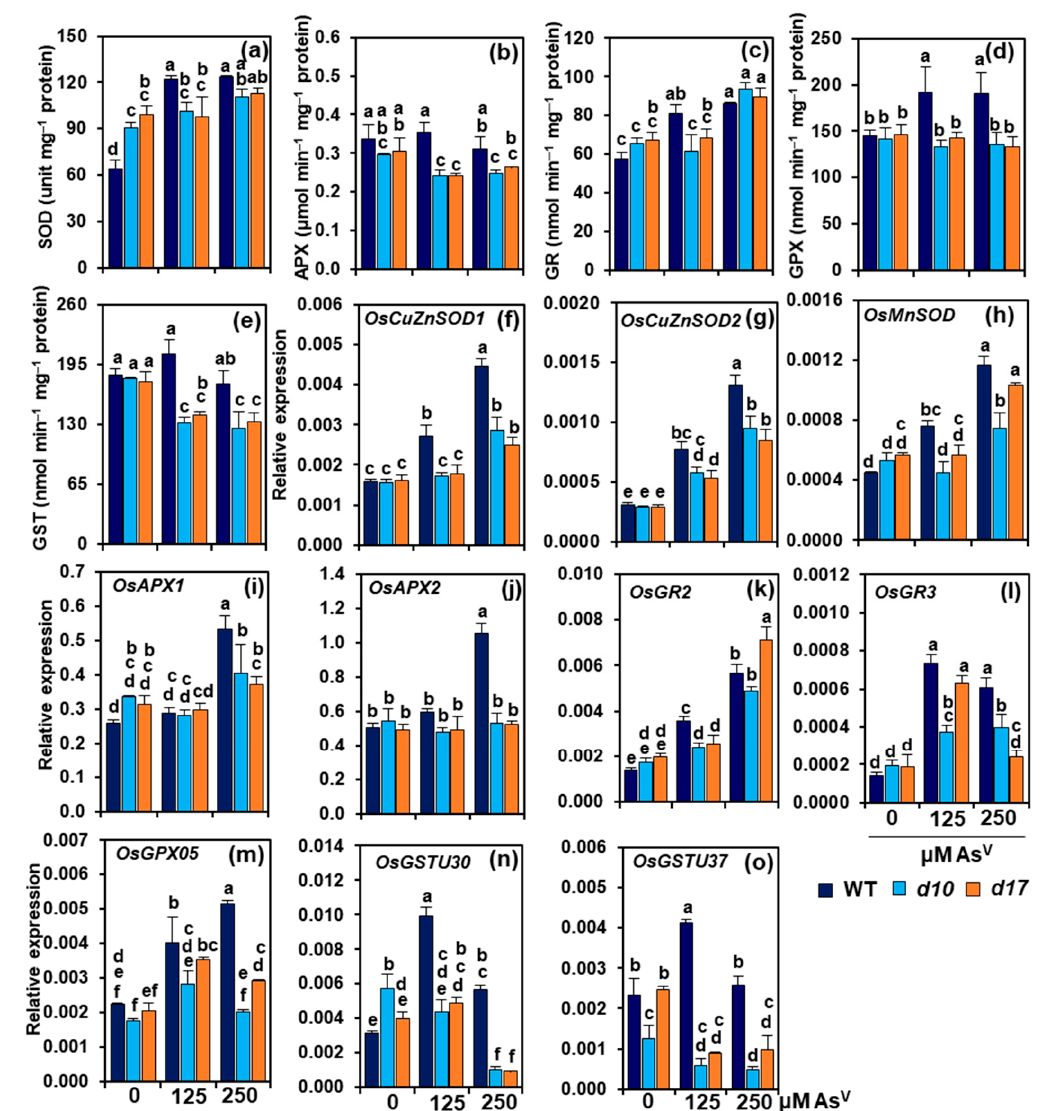
Figure 5. ( a – o ) Antioxidant enzyme activities and transcript levels of related genes in the shoots of wild-type (WT) and d10 and d17 mutant plants exposed to different concentrations of sodium arsenate (Na 2 AsO 4 ; 0, 125 and 250 µ M As V ). ( a – e ) Superoxide dismutase (SOD) ( a ), ascorbate peroxidase (APX) ( b ), glutathione reductase (GR) ( c ), glutathione peroxidase (GPX) ( d ) and glutathione S -transferase (GST) ( e ) activities in the shoots of three genotypes on day 3 of As V treatments. ( f – o ) Relative expression of biosynthetic genes of SOD ( OsCuZnSOD1 , OsCuZnSOD2 and OsMnSOD ) ( f – h ), APX ( OsAPX1 and OsAPX2 ) ( i , j ), GR ( OsGR2 and OsGR3 ) ( k , l ), GPX ( OsGPX05 ) ( m ) and GST ( OsGSTU30 and OsGSTU37 ) ( n , o ) enzymes in the shoots of WT, d10 and d17 on day 3 of the As V treatments. Represented numerical data are the means with standard errors ( n = 3 biological repeats). Significant differences ( p < 0.05) among the treatments are denoted by distinct alphabetical letters according to a least significant difference test.